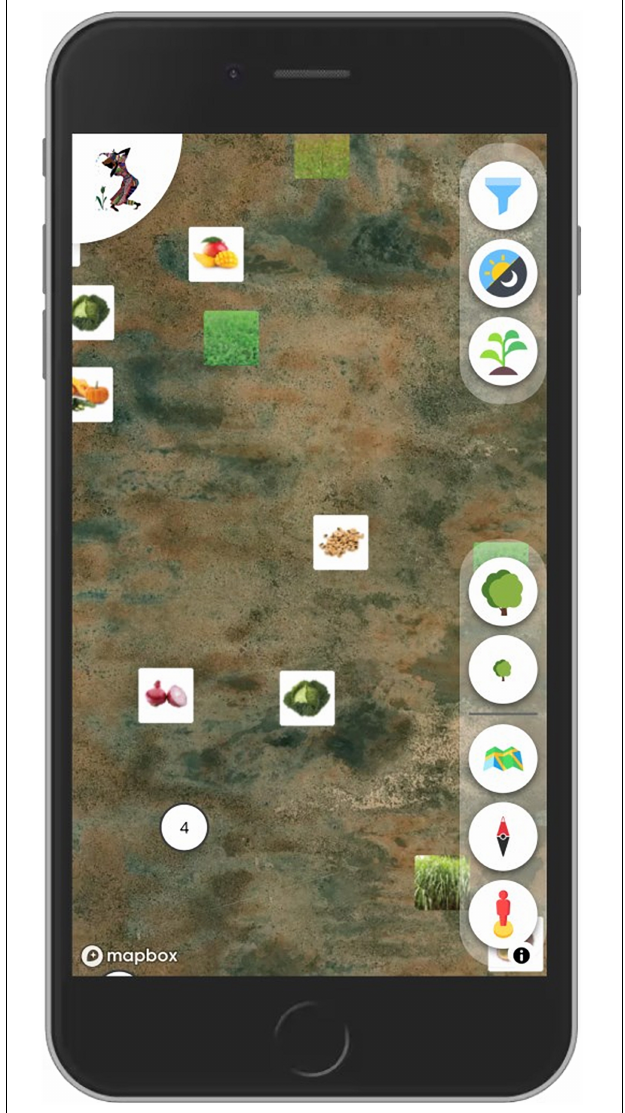
FIGURE 3 | Sapelli viewer (prototype with basic viewing